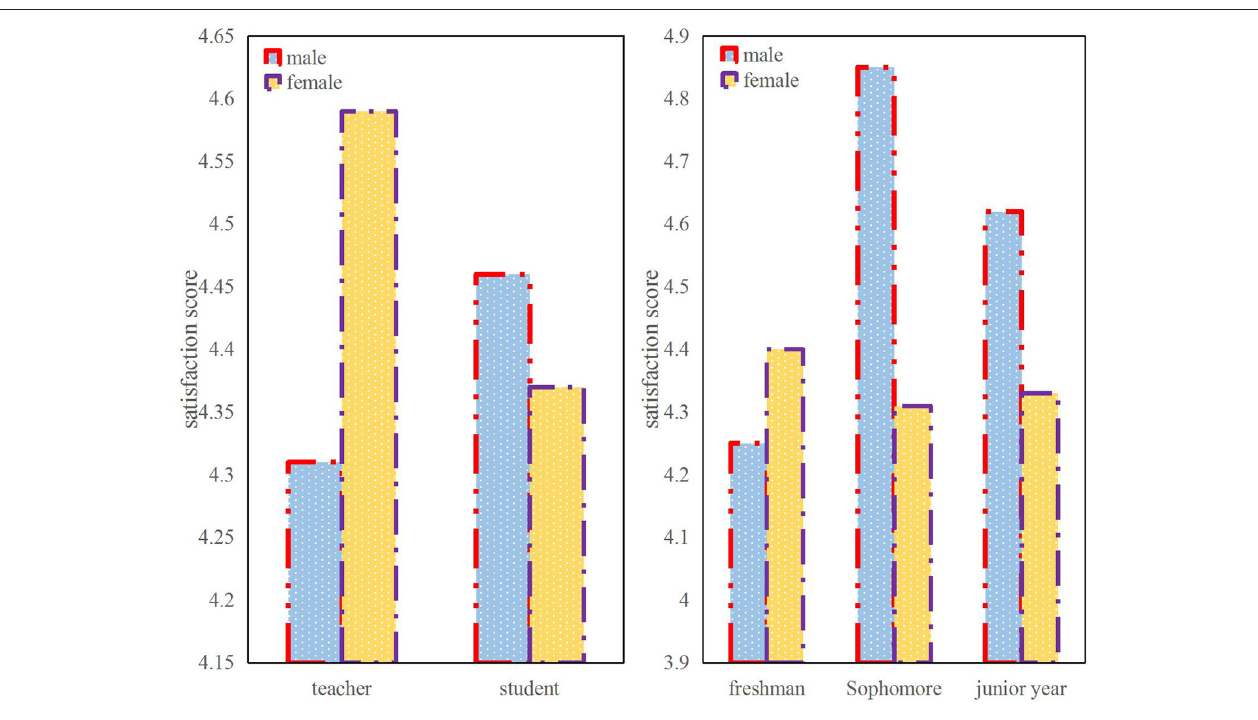
FIGURE 5 | Comparison of overall satisfaction among different